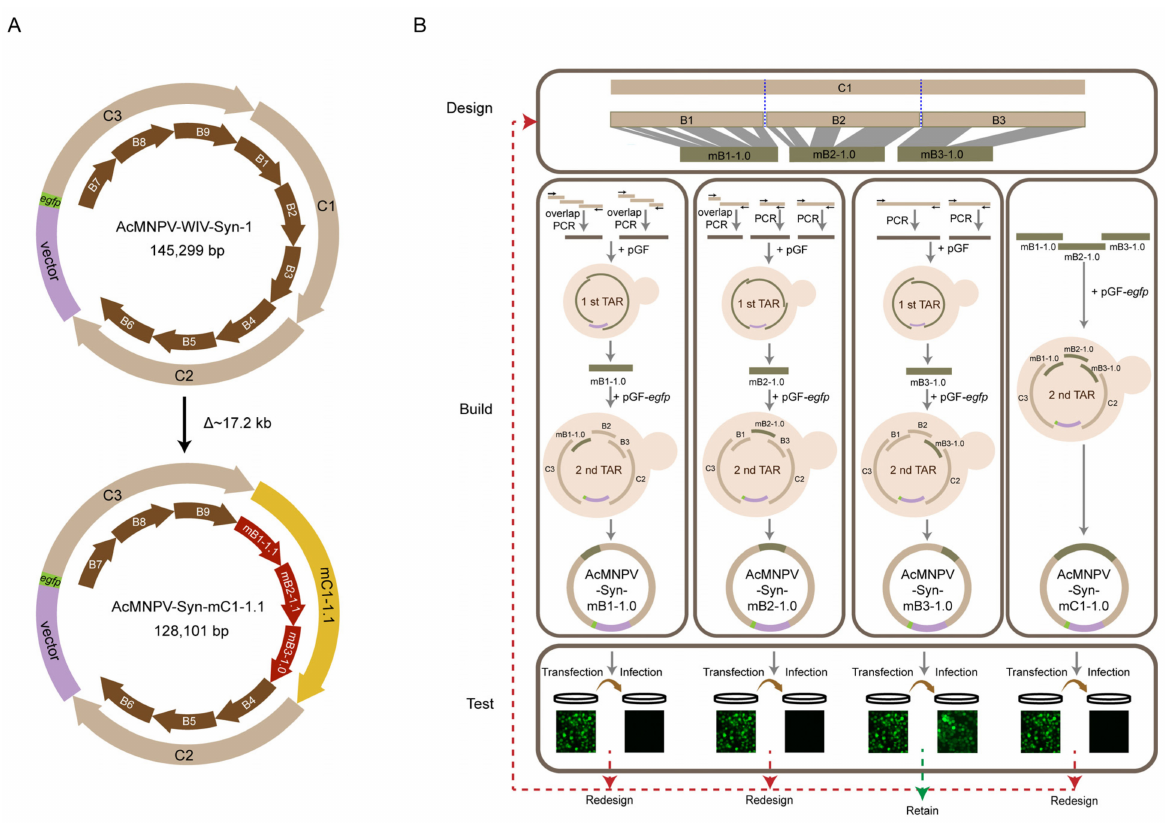
Figure 1. Flowchart of constructing AcMNPV genome containing modified C1 fragment. ( A ) Circular maps of the parental genome of AcMNPV-WIV-Syn1 and the modified AcMNPV-Syn-mC1-1.1. ( B ) The design-build-test cycling method to modify C1 fragment. The design of the modified C1 was based on the modification of B1, B2, and B3 fragments. Non-essential genes of each fragment were removed to generate modified fragments of mB1-1.0, mB2-1.0, and mB3-1.0. mB-1.0, mB2-1.0, and mB3-1.0 by overlapping PCR and used to generate modified genomes of AcMNPV-Syn-mB1-1.0, AcMNPV-Syn-mB2-1.0 and AcMNPV-Syn-mB3-1.0, respectively, using two steps of TAR in yeast. Meanwhile, AcMNPV-Syn-mC1-1.0 was generated using mB1-1.0, mB2-1.0, and mB3-1.0. To test, transfection and infection were performed; and the modified genome, which could not